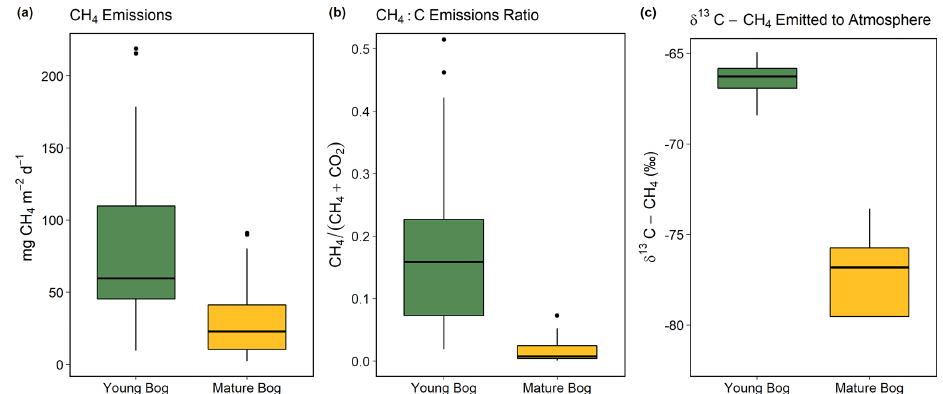
Figure 3. Magnitude and isotopic signature of greenhouse gas fluxes from the young bog (green) and mature bog (yellow) shown as boxplots. Boxes represent the interquartile range (25%–75%), with median shown as black horizontal line. Whiskers extend to 1.5 times the interquar- tile range (distance between first and third quartile) in each direction, with outlier data plotted individually as black dots. (a) The magnitude of net land–atmosphere CH 4 emissions as measured by soil chambers. (b) The ratio between CH 4 emissions and the sum of CO 2 emissions (ecosystem respiration) and CH 4 , both standardized to per gram C. (c) Intercept values of Keeling plots indicating the δ 13 C-CH 4 signature of CH 4 emissions. Isotopically heavier (i.e., less negative) δ 13 C-CH 4 is produced via acetoclastic methanogenesis, whereas isotopically lighter (i.e., more negative) δ 13 C-CH 4 is produced via hydrogenotrophic methanogenesis, The CH 4 and CO 2 land–atmosphere fluxes shown in (a) and (b) were measured once a month from May to September 2018. The δ 13 C-CH 4 of CH 4 emitted to the atmosphere was measured in September and October 2016 (see “Methods” for details and Fig. S4 for Keeling plots).